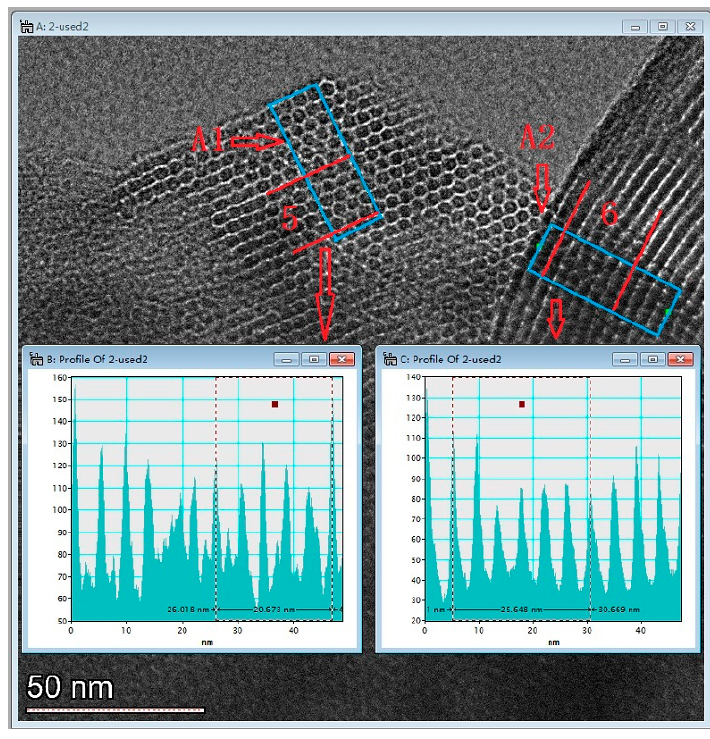
Figure 6. TEM images of AM41E-120-48. Figure 7 lists the SEM images of Al-MCM-41 synthesized at different crystallization temperatures and times. We can see honeycomb-like mesopores in each crystallization condition. However, many pores surrounded by the red rectangles in Figure 7g,h were distorted and showed worm-like shapes, illustrating that a noticeable decrease in pore order occurred when the crystallization temperature was 30 ◦